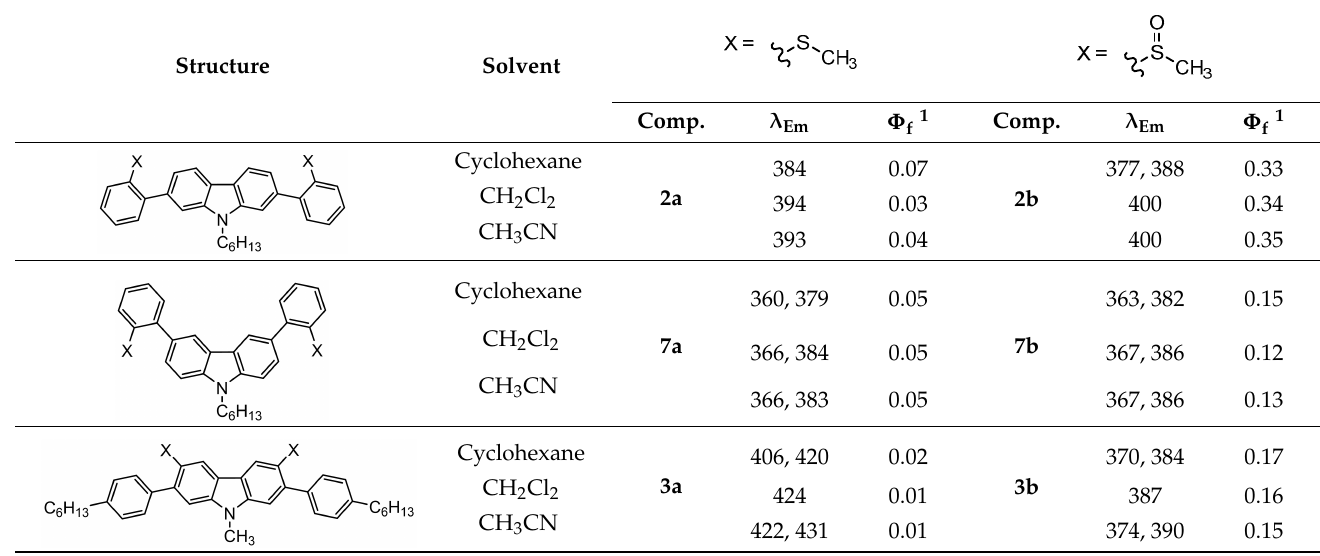
Structure Solvent Comp. Table 1. Photoluminescent characteristics of the sulfurated molecular structures 2 , 3 and 7 in different solvents. Table 1. Photoluminescent characteristics of the sulfurated molecular structures 2 , 3 and 7 in different solvents. Table 1. Photoluminescent characteristics of the sulfurated molecular structures 2 , 3 and 7 in different solvents. Table 1. Photoluminescent characteristics of the sulfurated molecular structures 2 , 3 and 7 in different solvents. Table 1. Photoluminescent characteristics of the sulfurated molecular structures 2 , 3 and 7 in different solvents. Table 1. Photoluminescent characteristics of the sulfurated molecular structures 2 , 3 and 7 in different solvents. Structure Structure Structure Structure Structure Structure